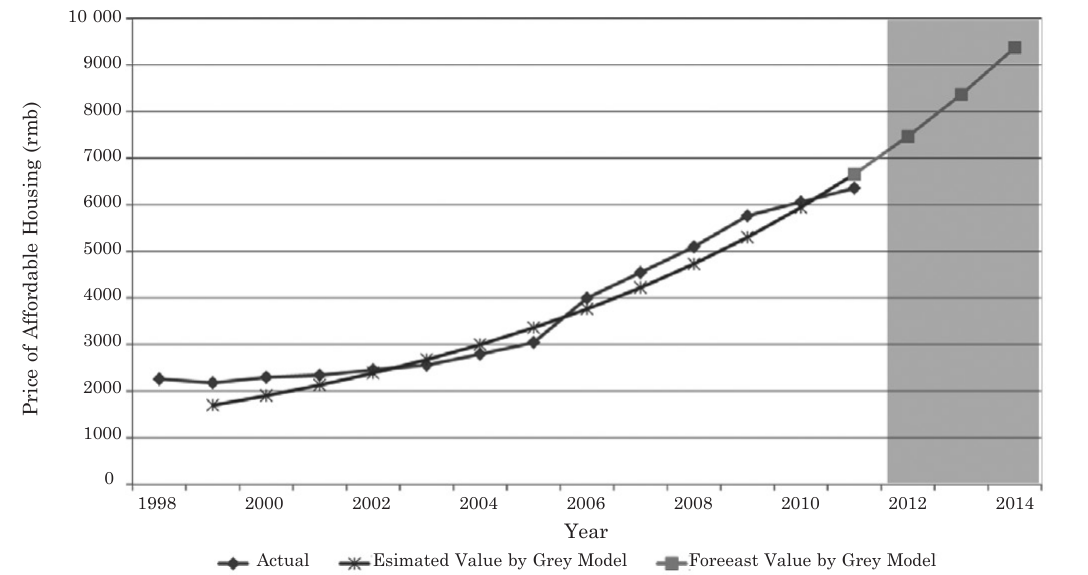
Actual Foreeast Value by Grey ModelEsimated Value by Grey Fig. 2. The actual, estimated and forecast value of affordable house prices by GM (1,1) model